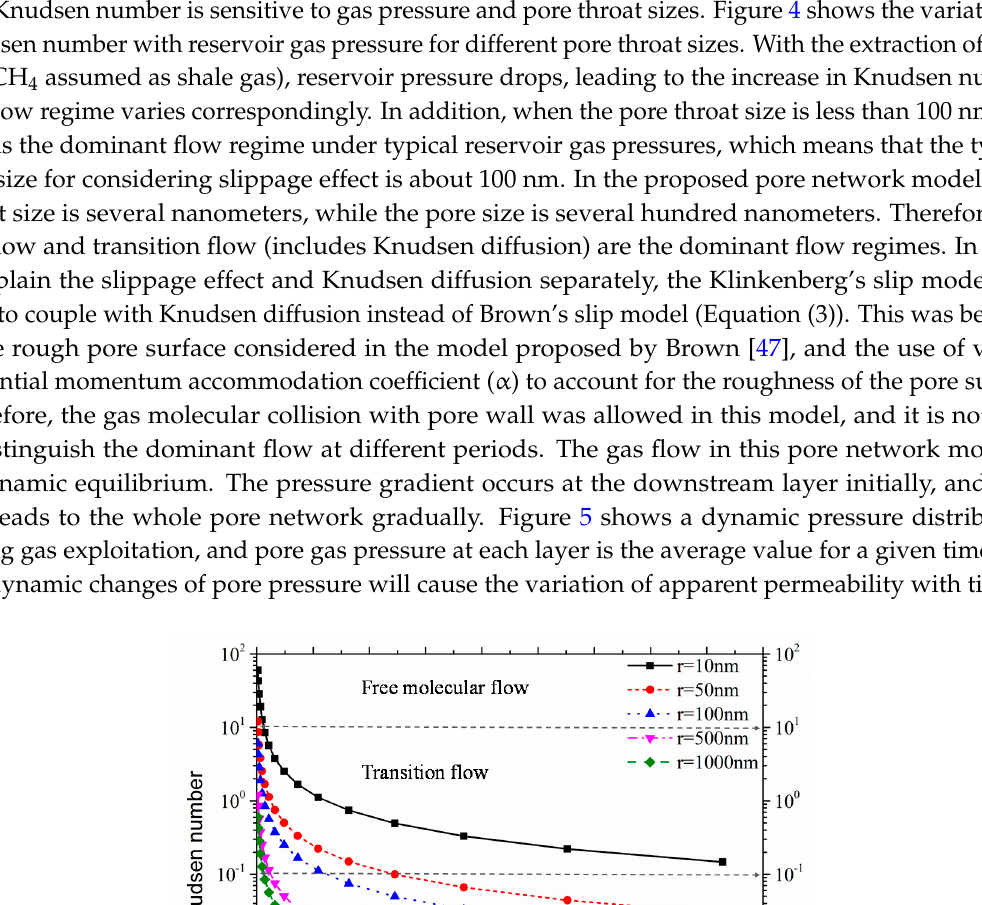
Figure 5. Dynamic gas pressure distribution with time along different layers. 3.2. Apparent Permeability of Shale Matrix Throat size determines the conductivity of flow paths in a shale matrix. Figure 6 shows the apparent gas permeability of shale matrix at different reservoir pressures based on the equivalent pore network model [35]. In this research, two types of pore throat size distributions were compared, specifically constant pore throat size and pore throat size obeying normal distribution. The difference is that reservoir pressure is extended to low pressure range so as to reflect the Knudsen diffusion and slippage effect at the later period of shale gas exploitation. The results indicate that apparent permeability decreases faster in a low pressure range. The apparent permeability is much higher at low pressures due to intensified Knudsen diffusion. Additionally, the results also show that the apparent permeability of constant pore throat size model is larger than that of the one obeying normal distribution, which means that the apparent permeability value of shale strongly relates to the proportion of small pore throats. It is the pore throat size rather than pore size that determines the gas flow regimes, and the sensitivity analysis result of average pore throat size is shown in Figure 7. The result indicates that apparent permeability increases logarithmically with the increases of average pore throat size. The simulated data was fitted to obtain a fitting equation that may provide insights to gas production. Here, the aspect ratio (pore throat size divided by pore body size) is quite small for shale matrix, and hence the pore throat sensitivity analysis was conducted only in a narrow range.